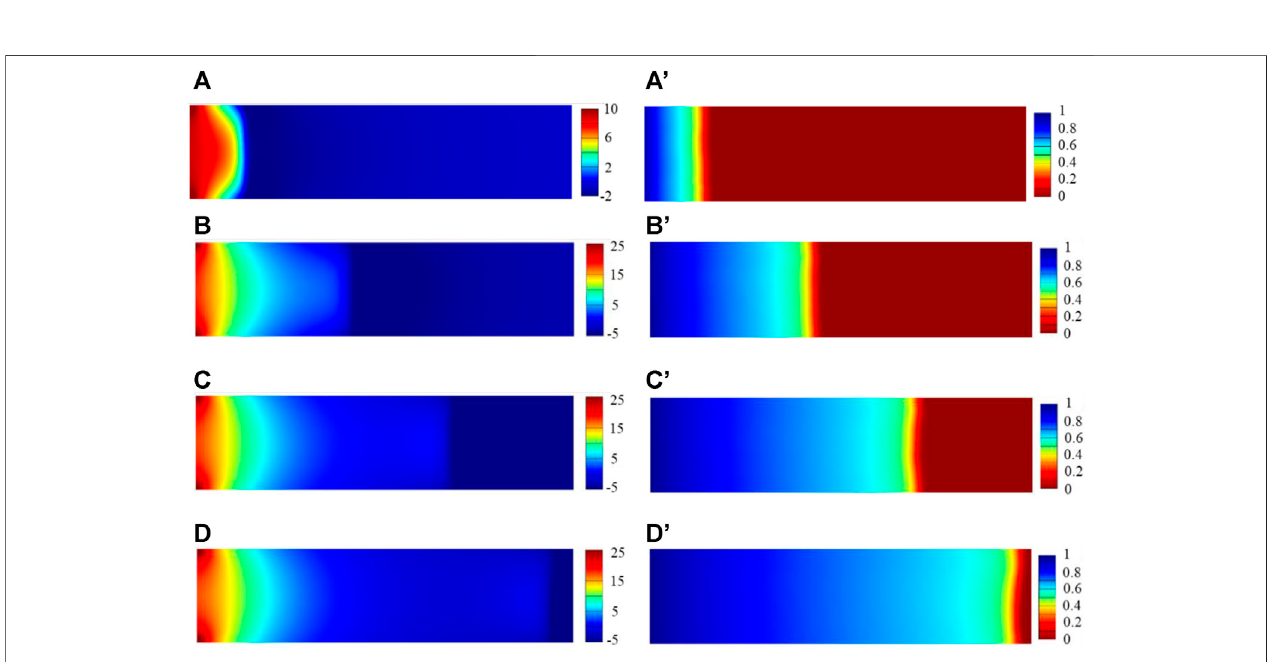
FIGURE 4 | The ferro fl uid saturation and magnetic anomaly distribution of numerical simulation at different time. (A – D) respectively show the magnetic anomaly at 10, 30, 50, 70 min; (A 9 -D 9 ) respectively show the saturation distribution at 10, 30, 50, 70 min.